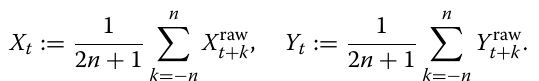
ˆ s : = arg max s min ≤ τ ≤ s max